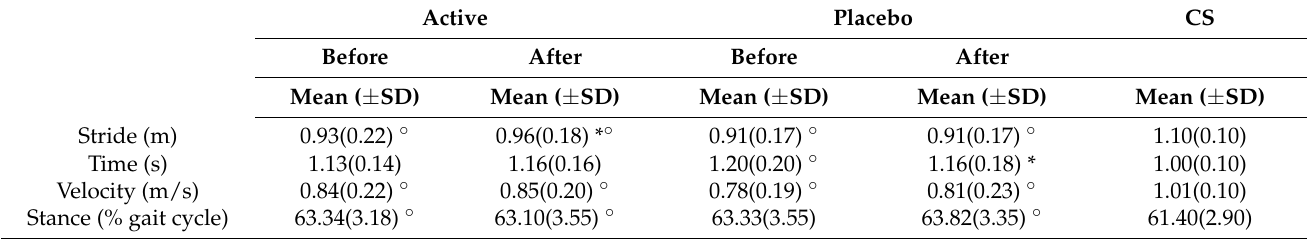
Figure 4. Envelope mean ± 1 standard deviation extracted from the surface electromyographic signal of each muscle analyzed: On the y-axis, the peak of the envelope (PoE in % of mean activation during gait), on the x-axis the gait cycle (from 0 to 100%). The bottom on the left tibialis anterior (TA) and on the right gastrocnemius lateralis (GL); down on the left rectus femoris (RF) and on the right biceps femoris (BF). In blue, PoE before placebo, in red after placebo, and in yellow normative bands of control subjects. Blue *: Before placebo compared with controls; red *: After placebo compared with controls; green *: Before placebo compared with after placebo. Table 2. Effectiveness of the treatments on spatio-temporal (ST)